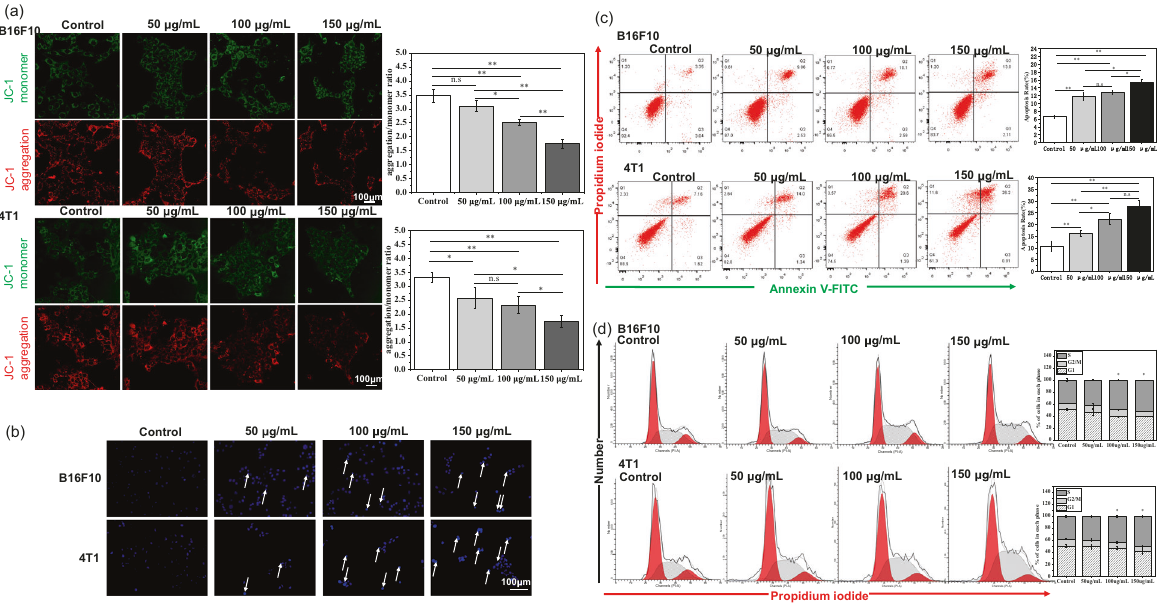
Fig. 5 JM2 induced apoptosis in the path of mitochondrion and cell cycle arrest. a Mitochondrial membrane potential detection of B16F10 and 4T1 cells cultured with JM2 solutions with different concentrations. The change of aggregation/monomer ratio represent the change of mitochondrial membrane potential. b Apoptotic cells exhibited nuclear chromatin aggregation after being treated with JM2 solutions with different concentrations (white arrows). c Apoptotic effects and quantitative analysis of B16F10 and 4T1 cells cultured with JM2 solutions with different concentrations. d Cell cycle analysis of B16F10 and 4T1 cells cultured with JM2 solutions with different concentrations. * p < 0.05 and ** p < 0.01 when the data was compared with the Control